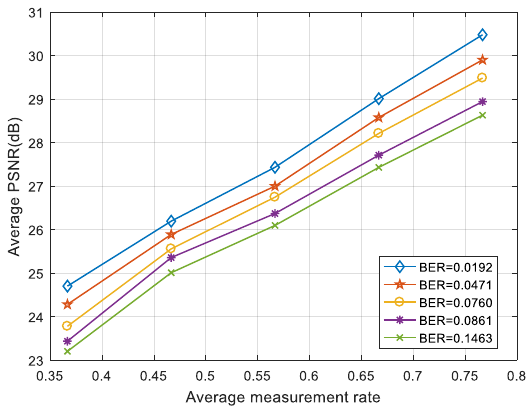
Figure 12. The AMR-PSNR performances for the